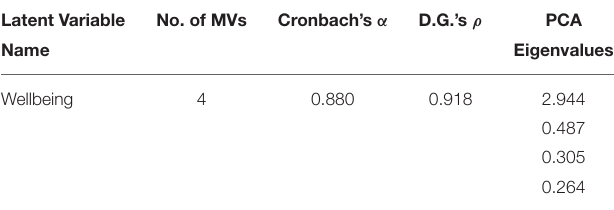
TABLE 2 | Unidimensionality of